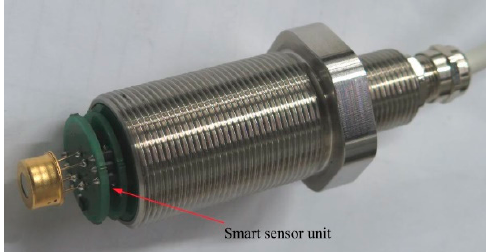
Figure 1. Measuring head based on smart sensor unit developed for the controlling of MEMS semiconductor sensors. Hot-replaceable smart sensor is marked by arrow. The substitution of this pre-calibrated part enables the utilization of different types of gas sensors (semiconductor, thermocatalitic, and others) with the same instrument.